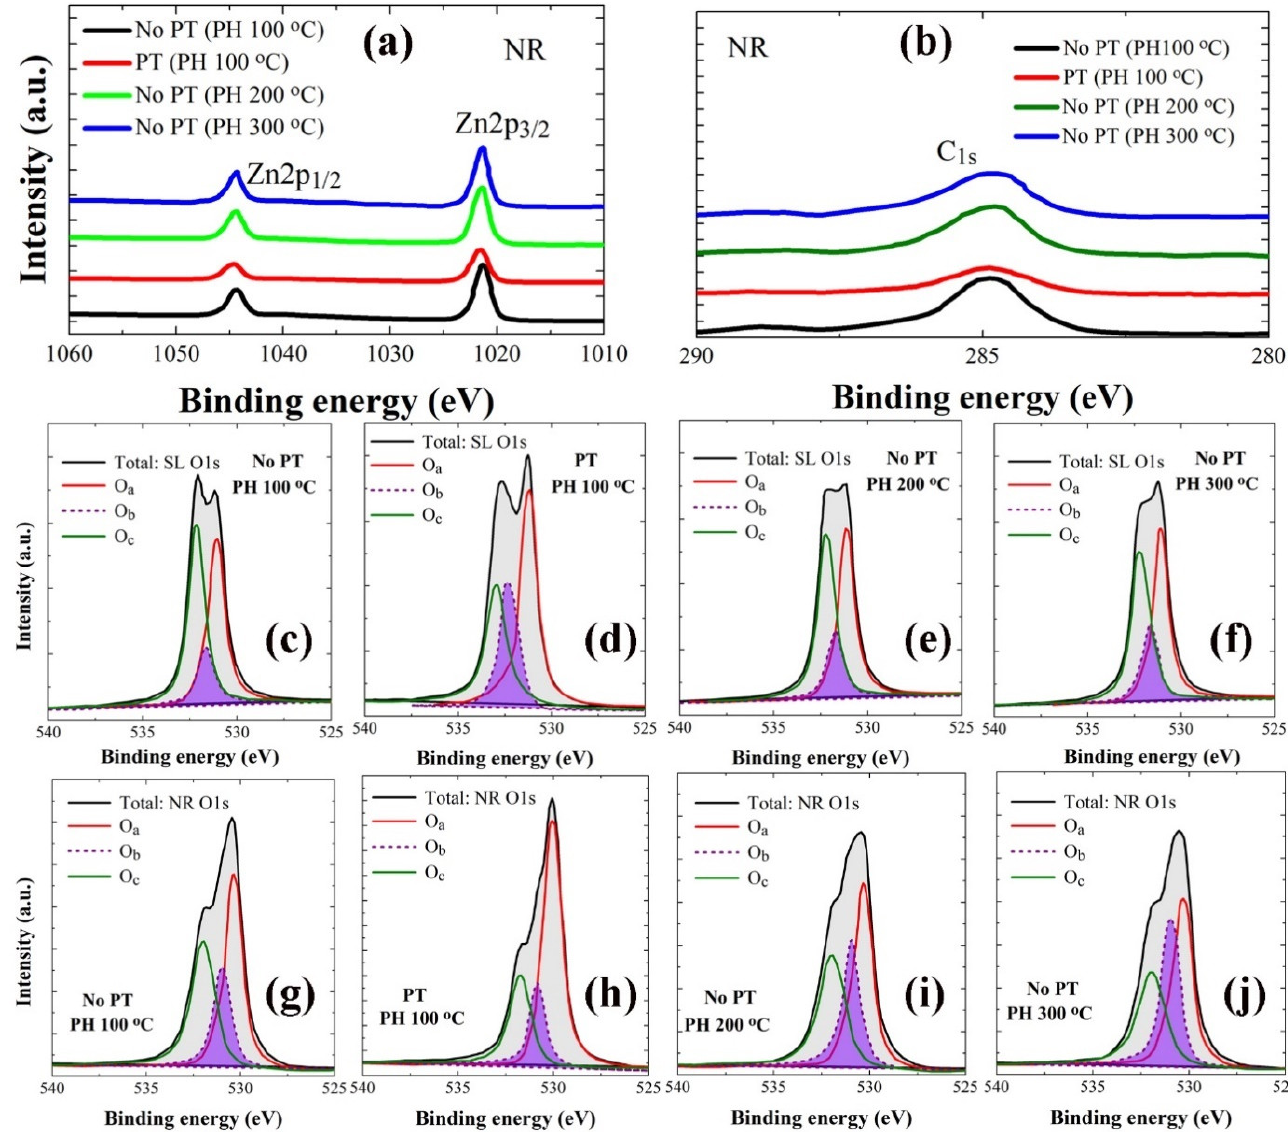
Figure 6. High-resolution individual core-level spectra of Zn 2p ( a ) and C 1s ( b ) from the NRs grown on the SL prepared under different conditions. Gaussian deconvoluted O 1s spectra from the SLs preheated at 100 °C ( c ), 200 °C ( d ), and 300 °C ( e ) and O 2 -plasma-treated SLs (PH at 100 °C) ( f ). The deconvoluted O 1s spectra from the NRs grown on the SLs prepared at each condition of ( c − f ) are also shown in ( g – j ).